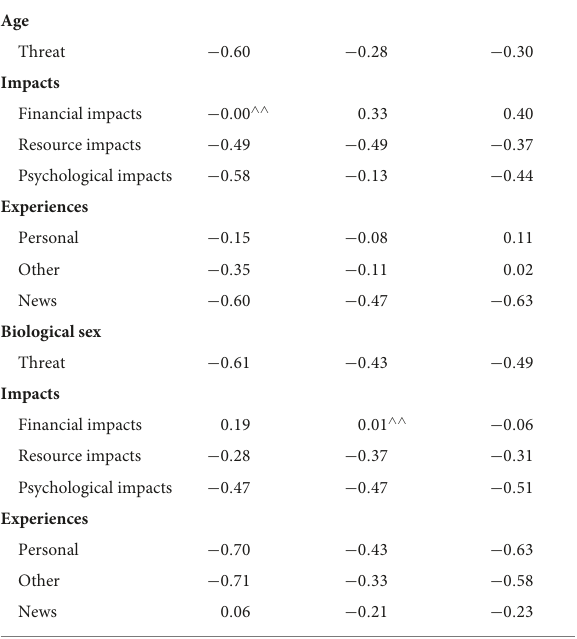
TABLE 10 Relative predictive validity of impacts/experiences, political beliefs, and trust in political messaging on perceived COVID threat across